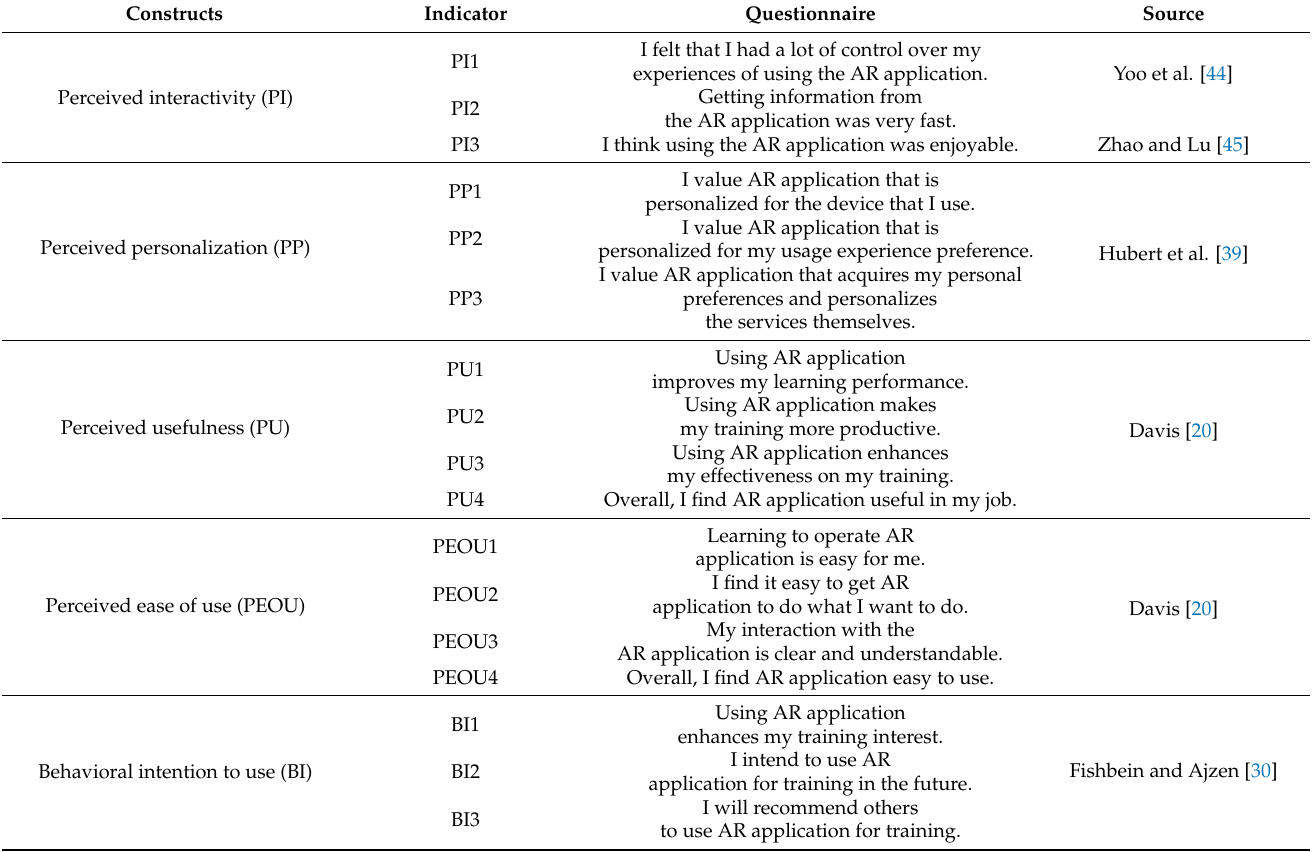
Table 2. Questionnaire details used in the